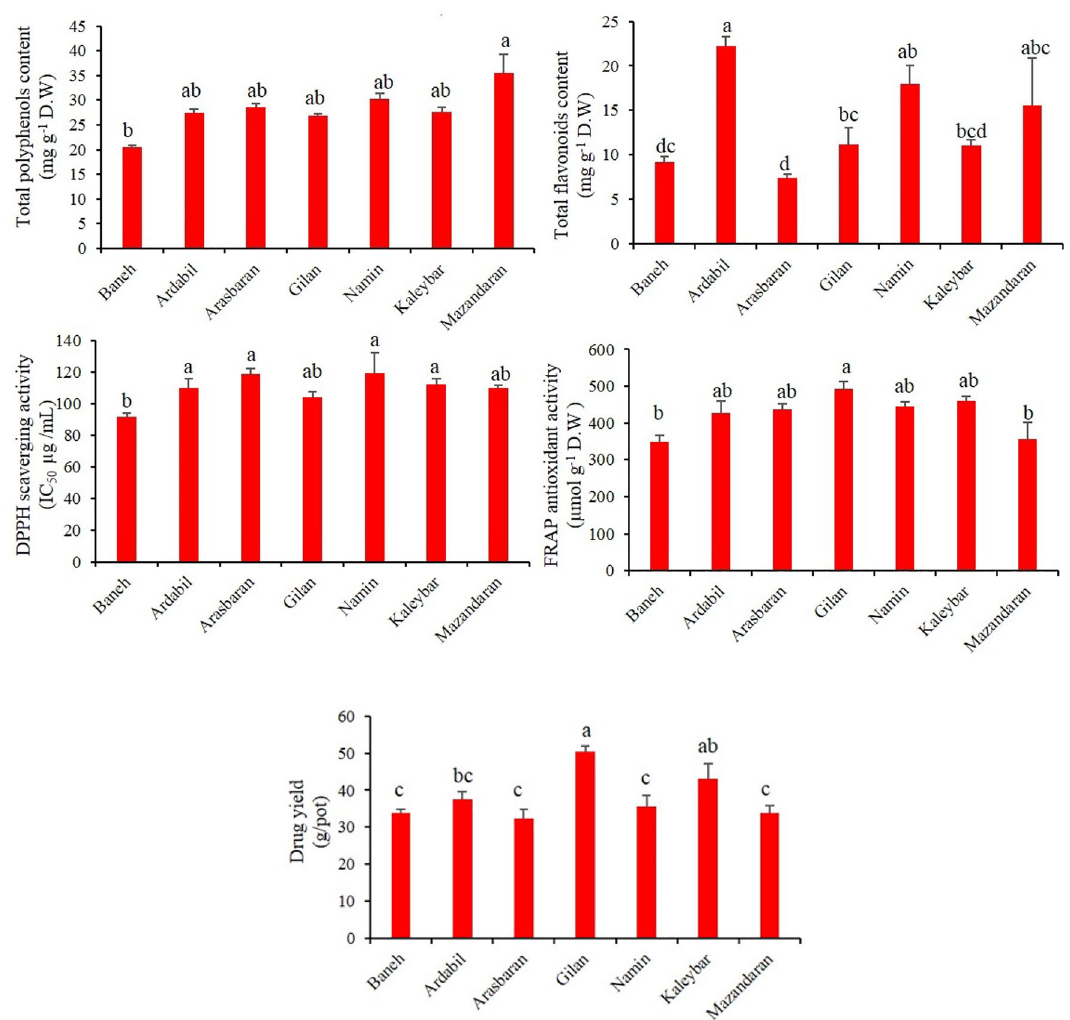
Figure 1. Mean values (n = 3) of yield and antioxidant biochemicals in seven oregano accessions. The error bars represent standard errors of the means. Different letters indicate significant differences ( p < 0.05) among the treatments within each genotype (LSD test at 5%